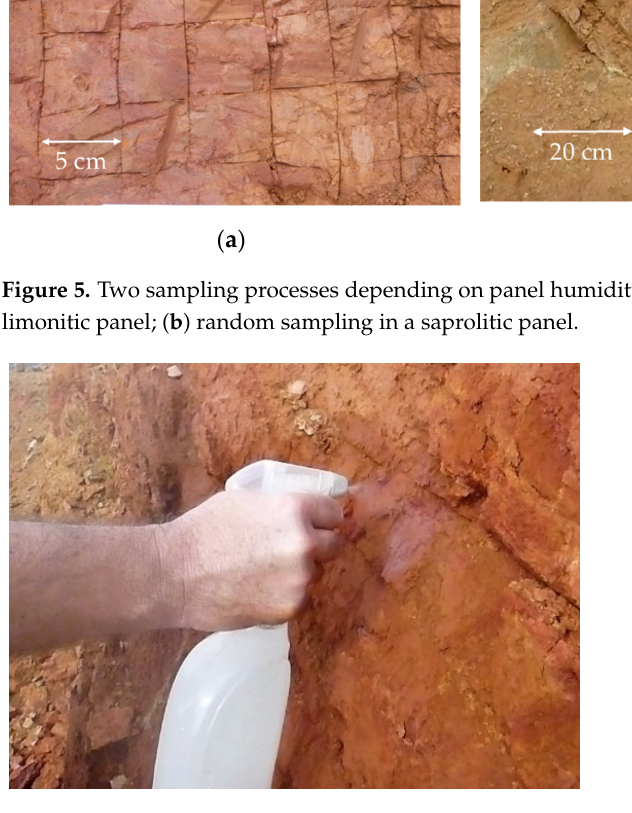
Figure 5. Two sampling processes depending on panel humidity and cohesion: ( a ) a 5 × 5 grid in a limonitic panel; ( b ) random sampling in a saprolitic panel.